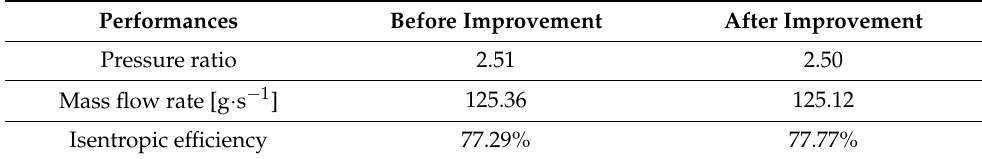
Table 10. Thermal performance before and after improvement.